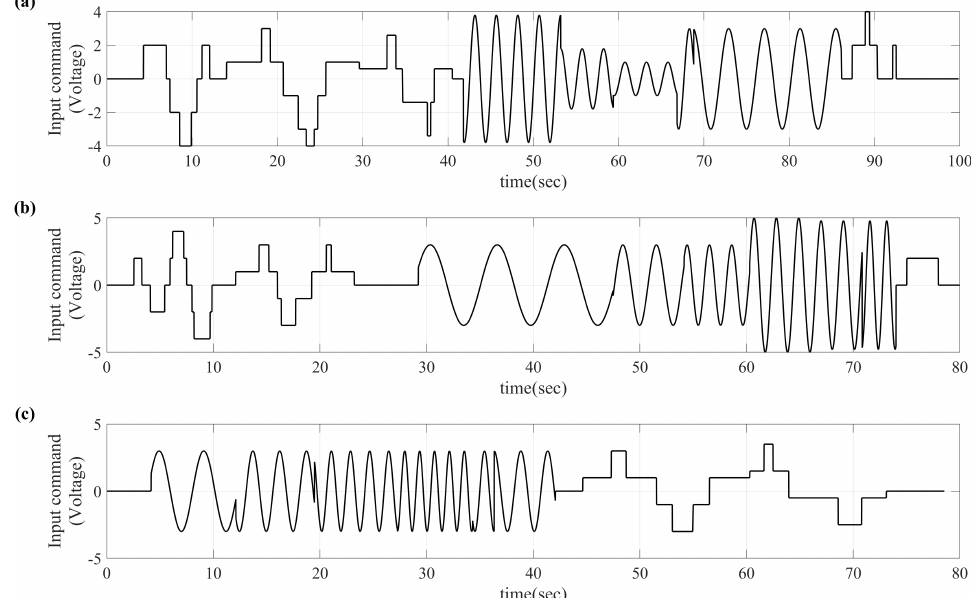
Figure 8. Random input commands to generate validation data sets: ( a ) Test Set 1, ( b ) Test Set 2, and ( c ) Test Set 3.